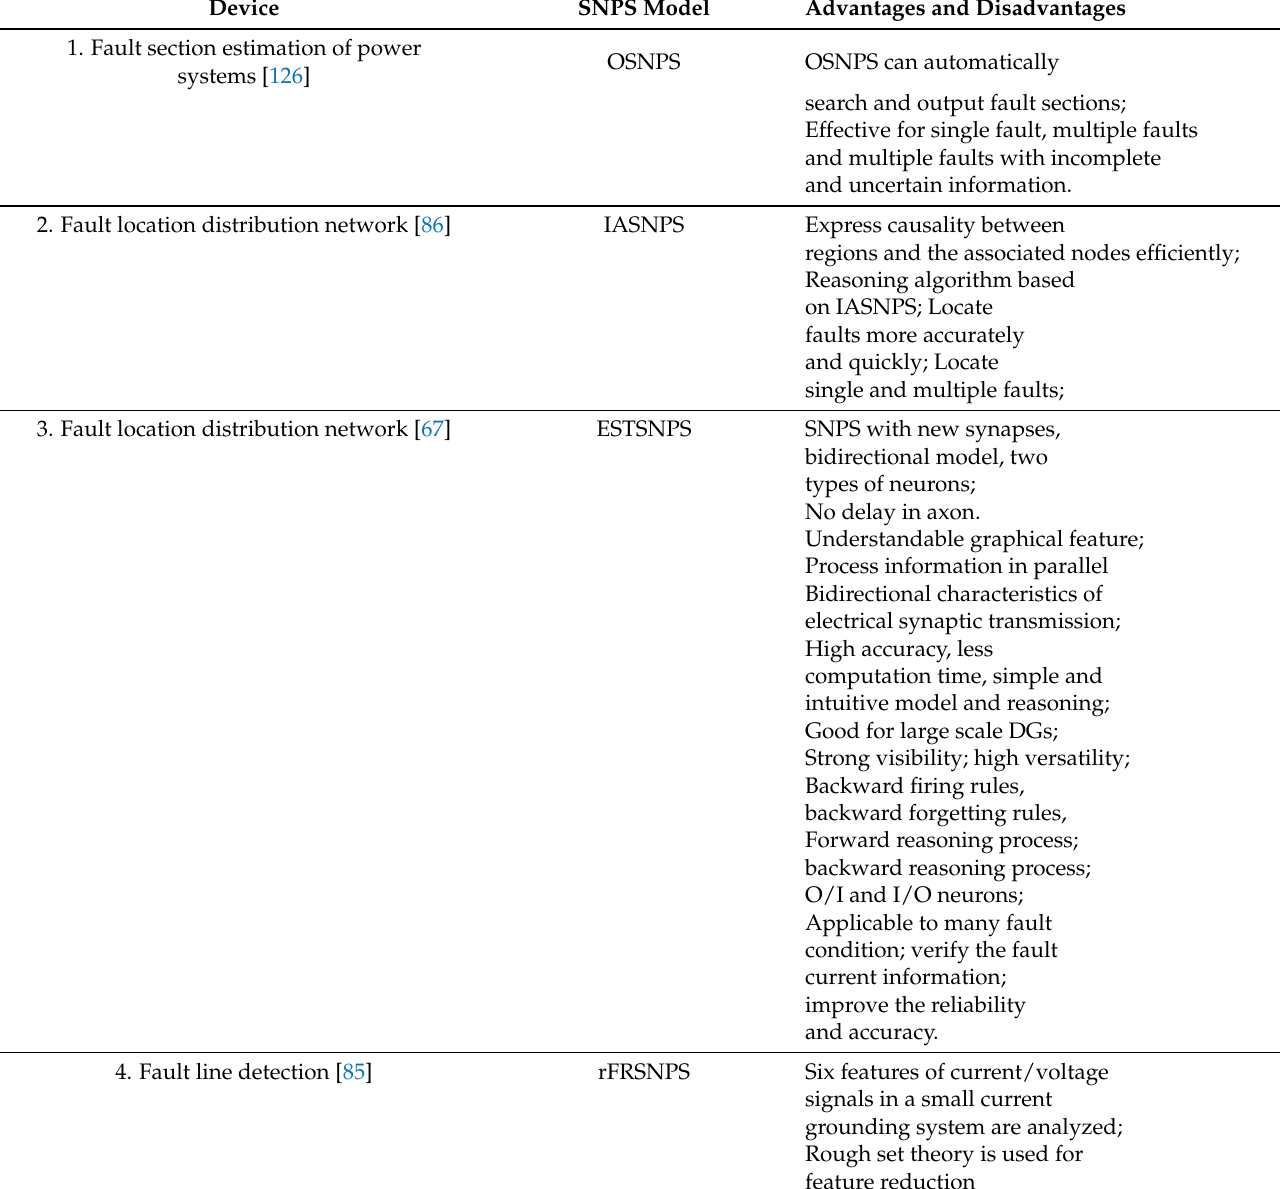
Table 5. Advantages and disadvantages of fault diagnosis models for fault location with spiking neural P